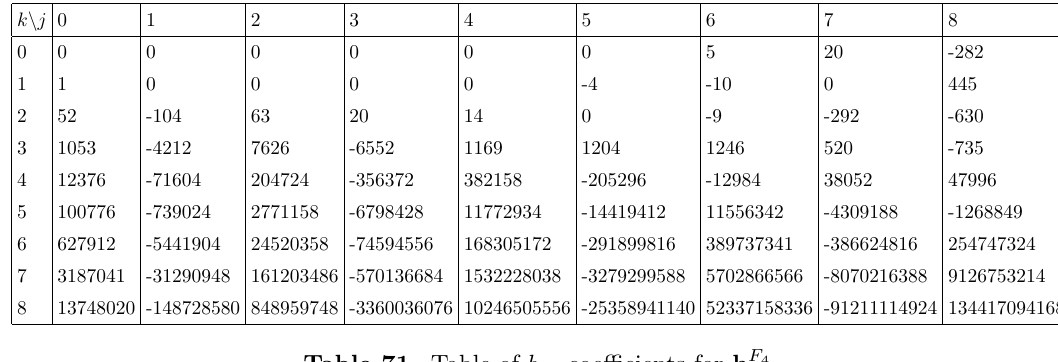
Table 71. Table of b jk coe(cid:14)cients for h F 4